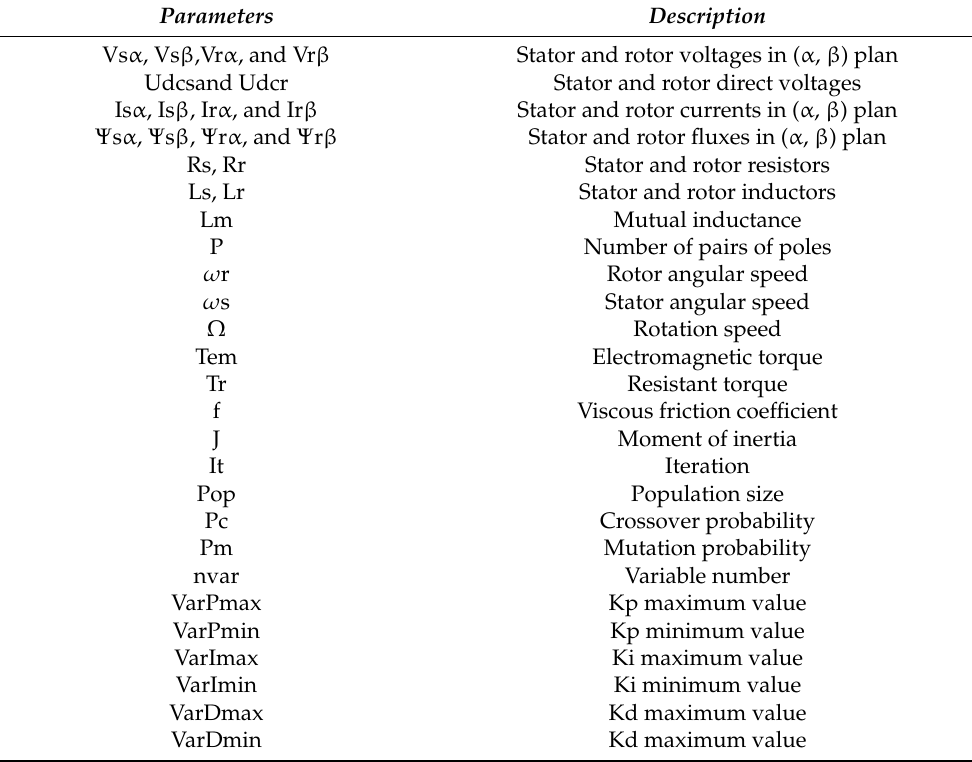
Table A3. Nomenclature.